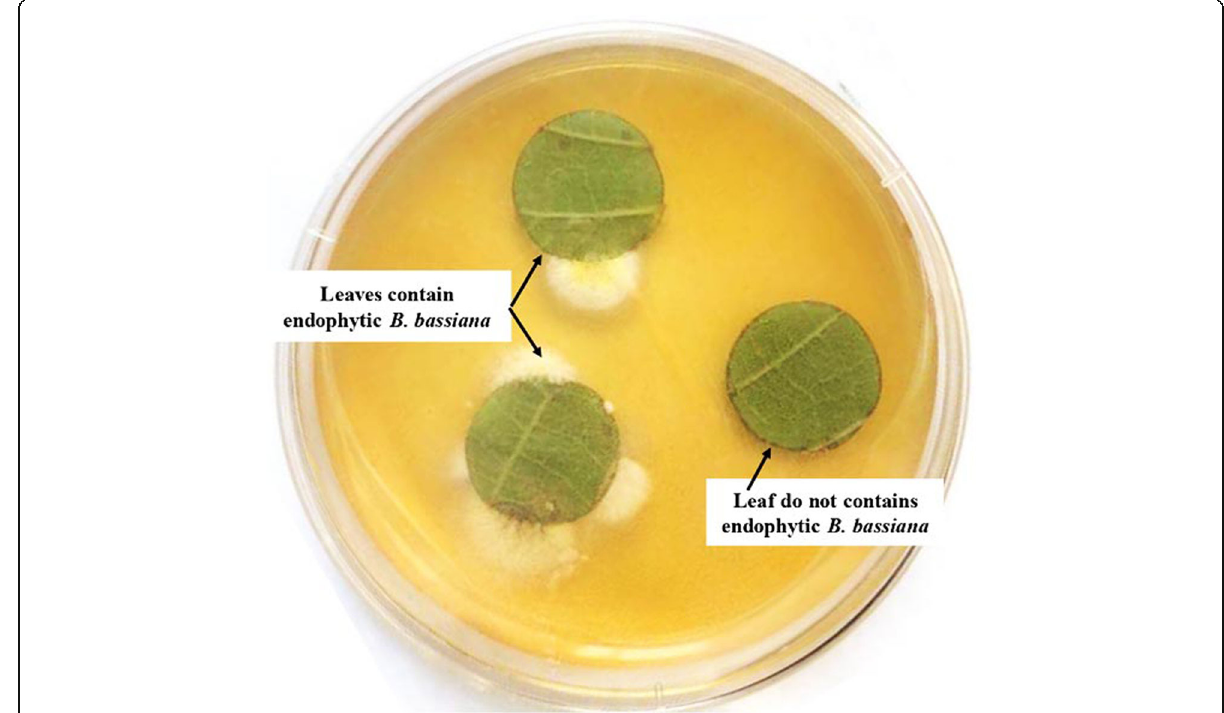
Fig. 1 Detection of endophytic entomopathogenic fungus ( Beauveria bassiana ) from leaves of Vitis venifera